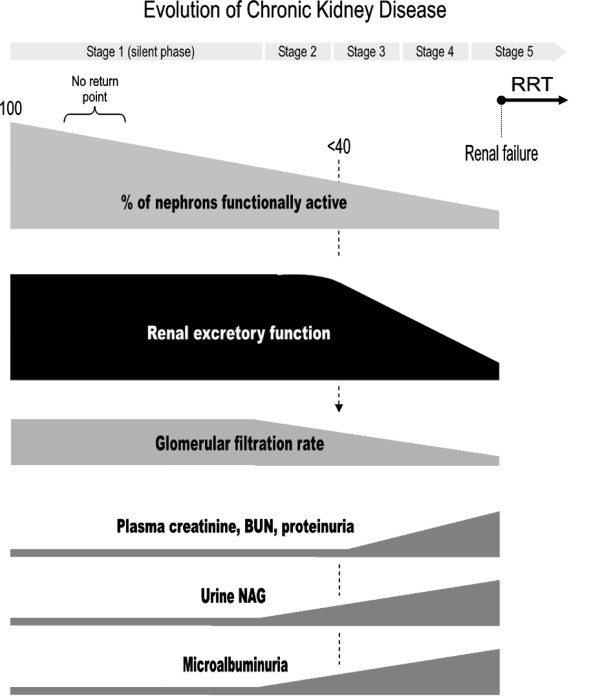
Graphic representation of the evolution of key pathological events, such as percentage of nephrons functionally active, overall renal excretory function and glomerular filtration rate, and plasma and urine markers associated with time course of chronic kidney disease. The figure shows the relative priority of appearance of these elements with repect to one another as it occurs in most cases of chronic kidney diseases. Their appearance, however, may vary from this general prototype in specific diseases or in determined cases. In the same way, the slope of increase or decline may also vary. RRT: renal replacement therapy, BUN: blood urea nitrogen, NAG: N-acetyl-β-D-glucosaminidase.